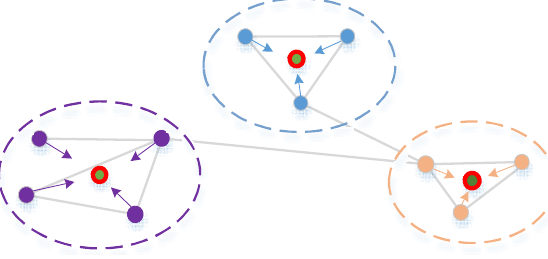
Figure 9. Multi-centroid constraint diagram.